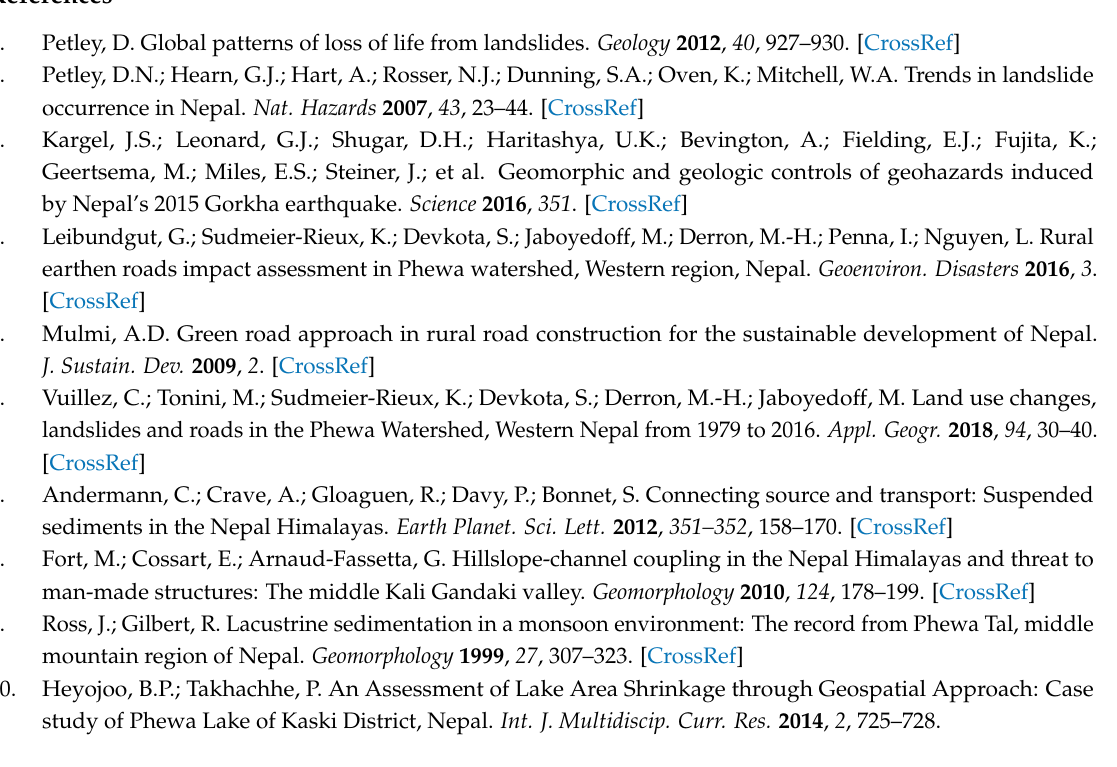
Table S1: ASTER Thermal Infrared (TIR) and Landsat Thermal Infrared Sensor (TIRS) imagery used to derive lake temperature. Table S2: RapidEye imagery used to derive normalised difference vegetation indexes. Figure S1: Lake area shrinkage due to the 1975 dam failure. The lake outline from 15th December 1972 is shown on all panels. (a–d) Landsat Multispectral Scanner background false colour composite (near-infrared, red, green). Figure S2: Surface water extent and change from Landsat image classification (Pekel et al., 2016). Figure S3: Landslide activity in the upper part of Phewa catchment (Figure 7) revealed by RapidEye true colour imagery. (a) 6 November 2013. (b) 17 December 2014. (c) 31 October 2015. Figure S4: Stone inscription used at the time of the inauguration of a dam on 16 January 1962. Figure S5. A 2015 landslide (a), sourced in the Kuncha formation and nearly reaching Harpan Khola, is composed of rocks such as these (b) shown in thin section (crossed polarizers)—pelitic schist (c) and psammitic schist (d), commonly forming meta-conglomerate ((b), right). In (c) and (d), Qz = quartz, Ms—muscovite, and Bt = Biotite; and the scale bar is 0.6 mm. Panel (a) is a DigitalGlobe scene projected in Google Earth, acquisition date March 10, 2016. Figure S6: Environmental water quality and ecological problems of Phewa Lake. (a) Outlet pipe emits wastewater into the lake, where fishermen extract fish. (b) Evidence of the wastewater effects on water quality. (c) Water hyacinth, an aggressive invasive species from the Amazon Basin has invaded Phewa Lake. (d) Plastic pollution and water